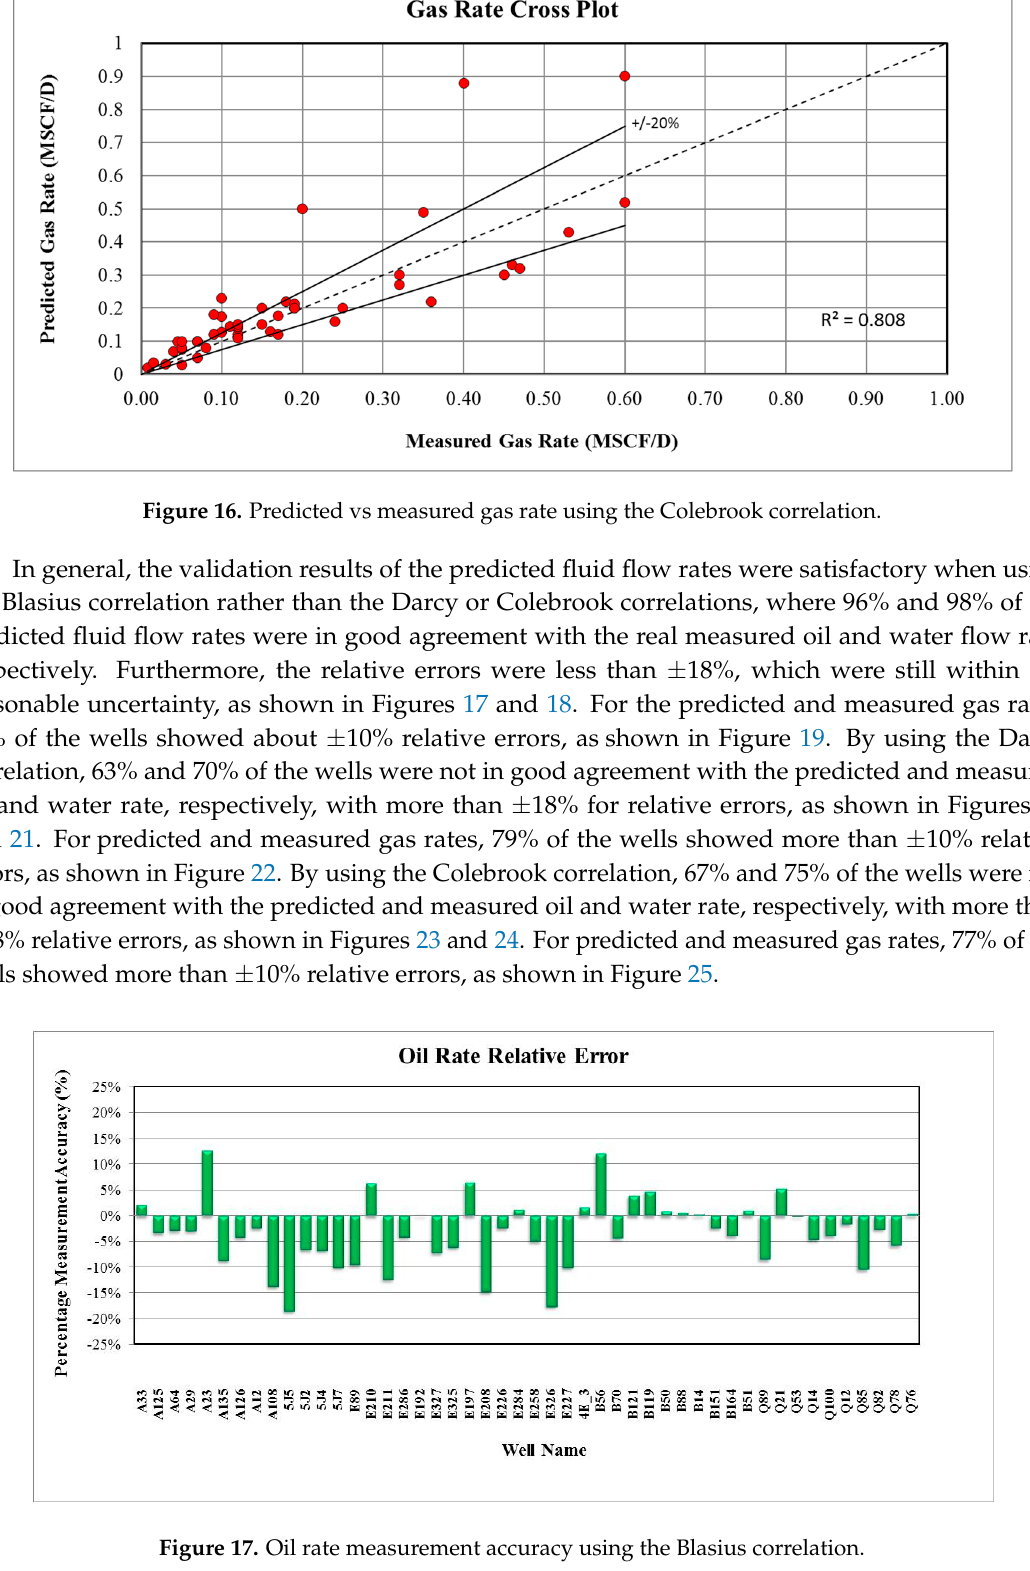
Figure 15. Predicted vs measured water rate using the Colebrook correlation.